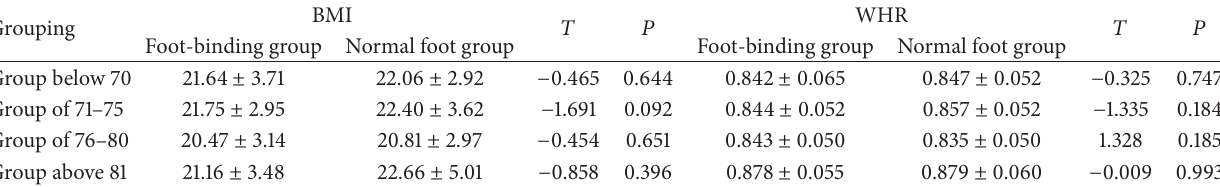
Table 4: Body comparison according to age groups between normal foot group ( 𝑛 = 104 ) and foot-binding group ( 𝑛 = 204 ). BMI 𝑇 𝑃 WHR 𝑇 𝑃 Grouping Foot-binding group Normal foot group Foot-binding group Normal foot group Group below 70